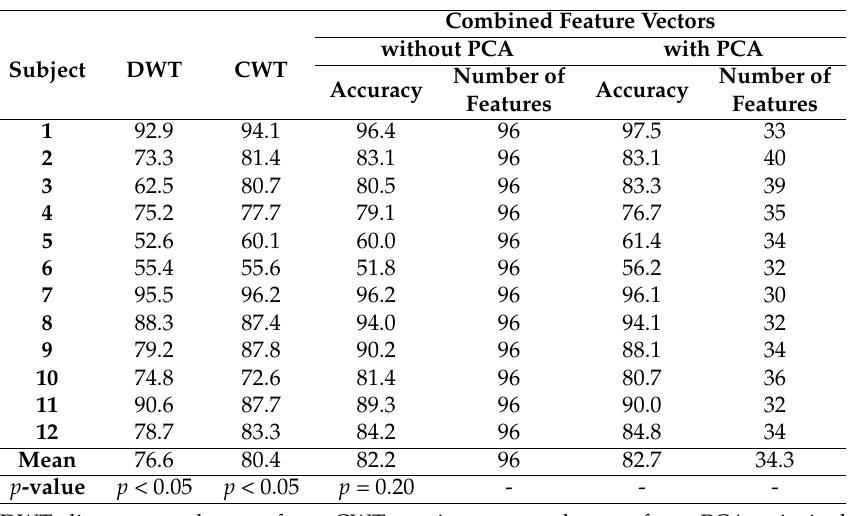
Table 2. Comparative results of the feature extraction methods in terms of the average classification accuracy